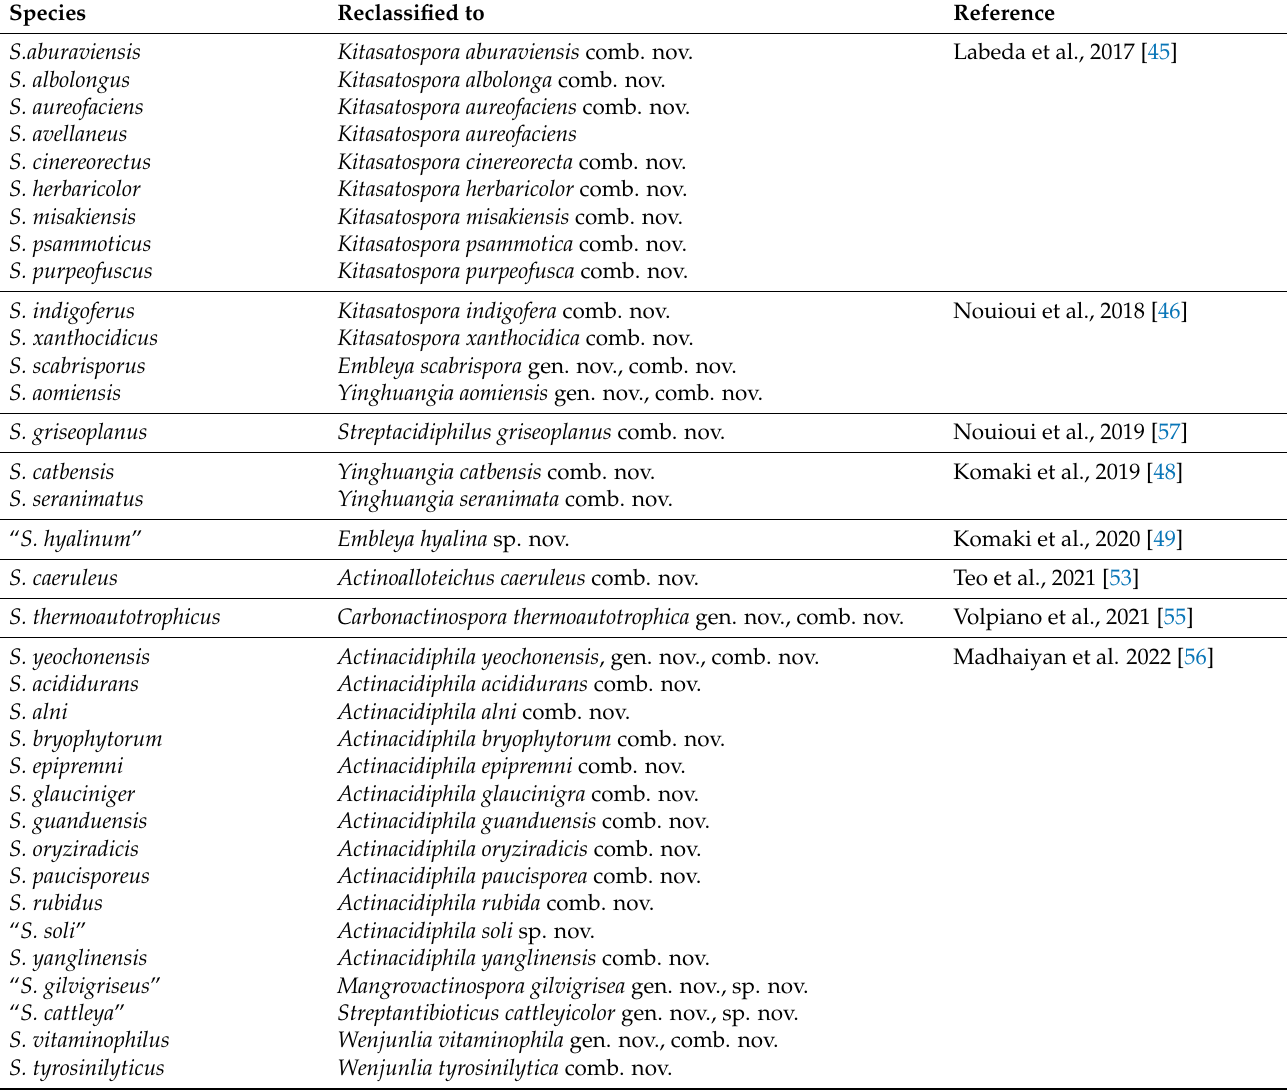
Table 1. Streptomyces species transferred to other